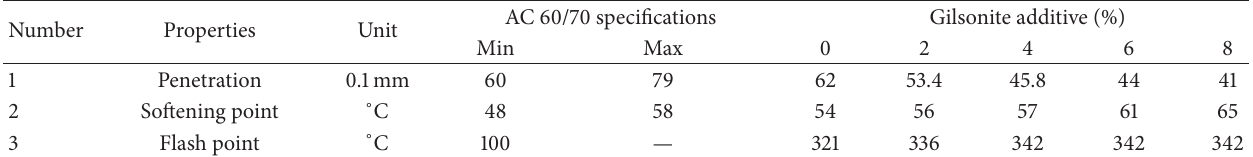
Table 2: Properties of asphalt AC 60/70 mixed with Gilsonite additive.